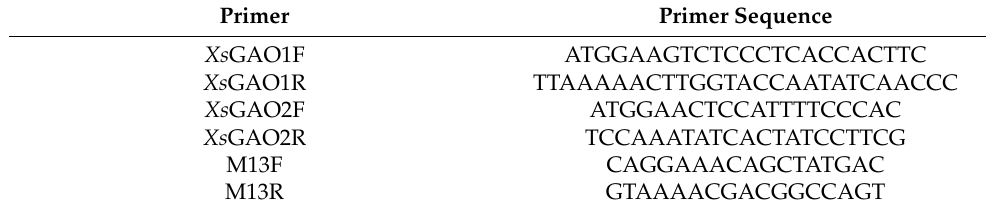
Table A1. Primers used in GAO gene cloning.